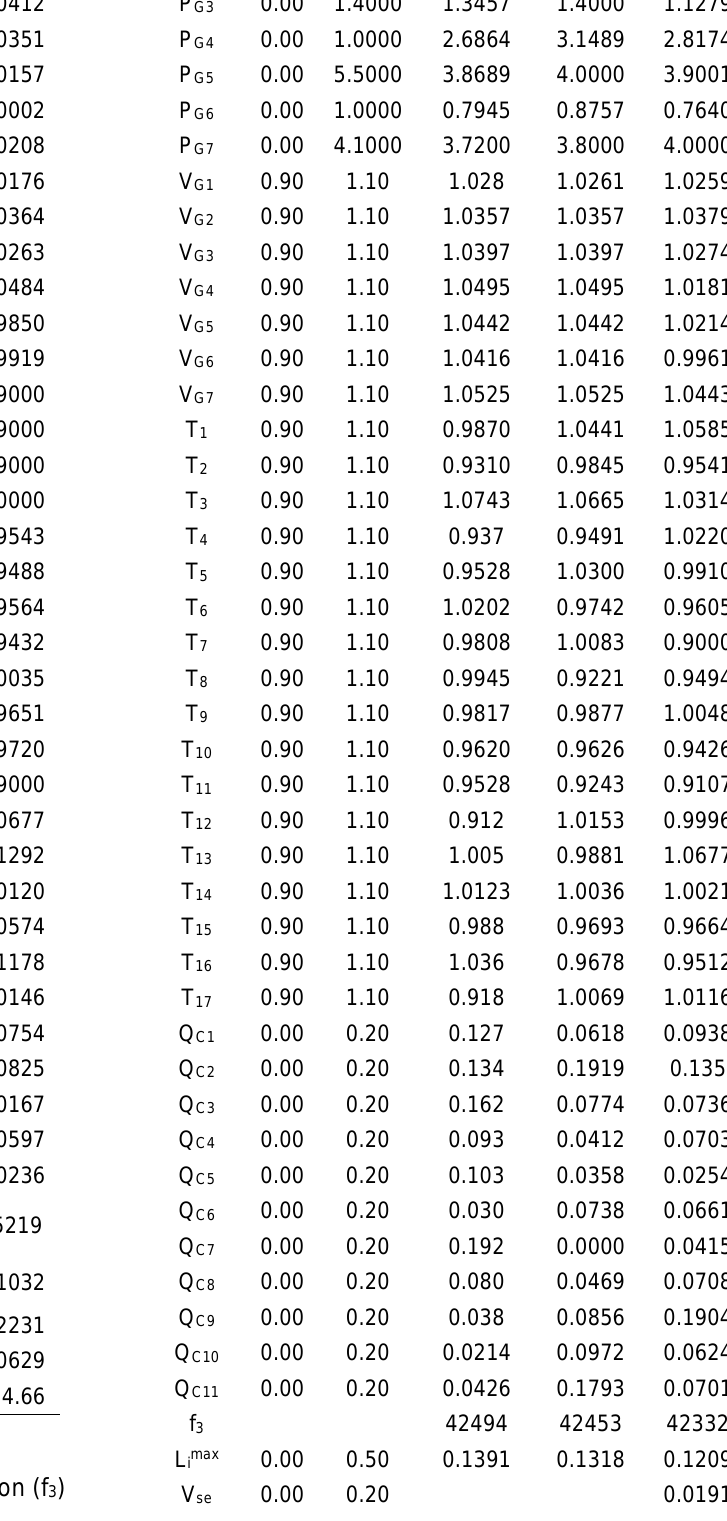
Table 10. OPF results for multi-objective function (f 3